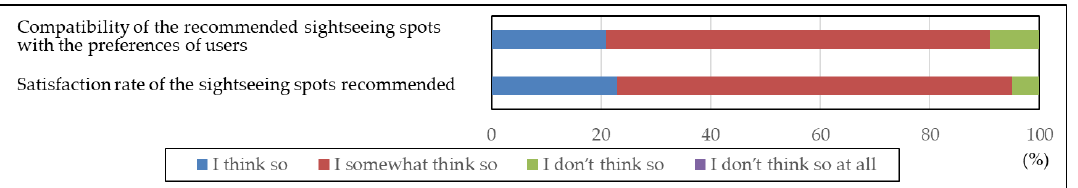
Figure 10. Evaluations concerning the recommendation function of sightseeing spots adopting collaborative recommendations.